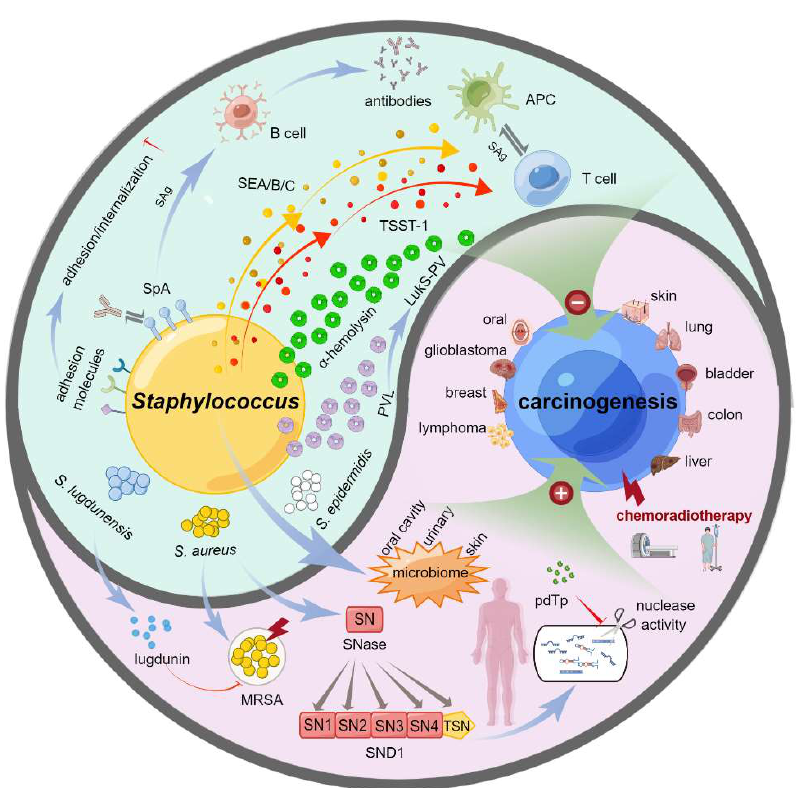
Figure 1. Bidirectional functional effects of Staphylococcus on carcinogenesis . Staphylococcus has the bidirectional effects on carcinogenesis in various types of cancers, such as skin cancer, lung cancer, bladder cancer, colon cancer, liver cancer, lymphoma, breast cancer, glioblastoma, and oral cancer. On the one hand, the changes of staphylococcal flora in some tissues of the body, such as oral cavity, skin or urinary system, was linked to the predisposition to cancer or detected in cancer cases undergoing chemotherapy and/or radiotherapy. MRSA is often associated with a reduced survival rate of patients with malignant tumors. SNases work as the extracellular nucleases of S. aureus , and there exists a human homologue of SNases, SND1, which is closely related to the occurrence and development of different cancers. On the other hand, S. lugdunensis can secrete a lugdunin to curb the reproduction and infection of MRSA. S. aureus may play the role of tumor inhibition through the points of bacterial toxins (alpha-hemolysin, PVL or LurkS-PV), superantigens (SEA/B/C, TSST-1, SpA) of T/B cells, or adhesion molecules. Additionally, the inhibition of SND1 nuclease activity by pdTp may be an effective intervention or therapeutic strategy for liver cancer. This figure was drawn by Figdraw.